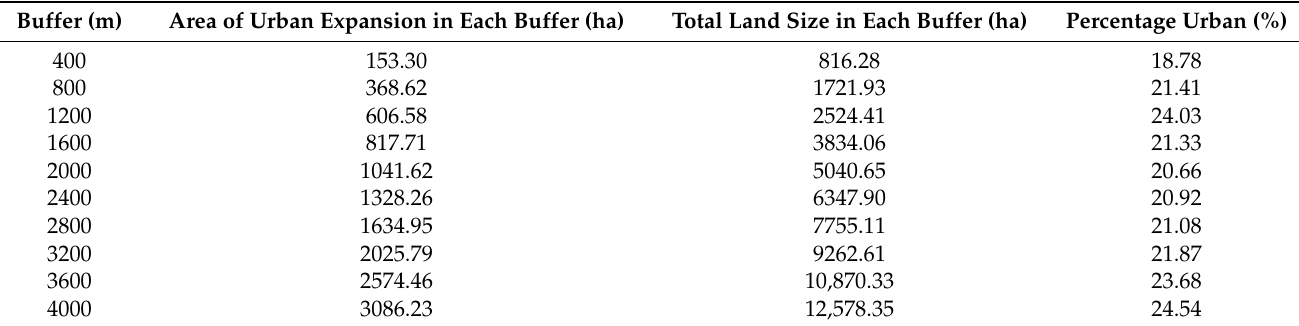
Table 8. Urban, total area and percentage urban in